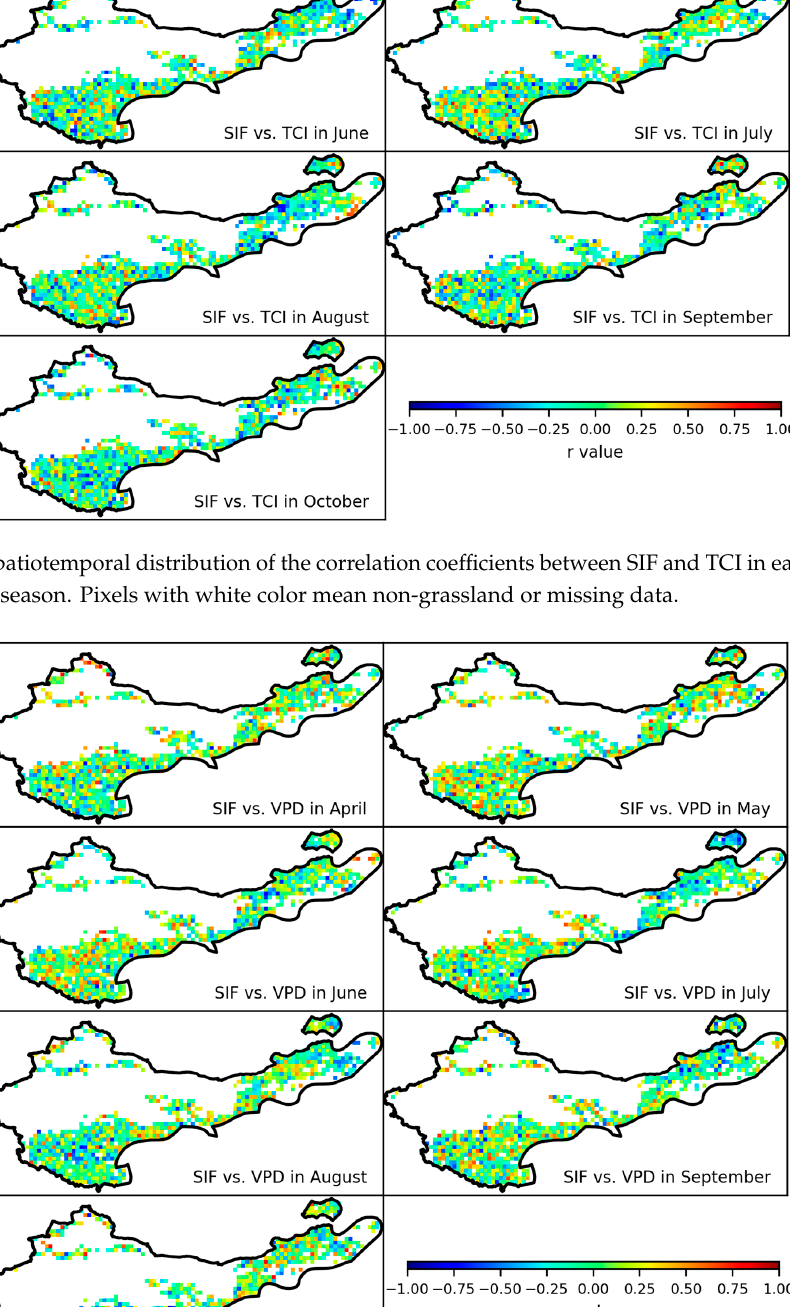
Figure 8. Spatiotemporal distribution of the correlation coefficients between SIF and VPD in each month of growing season. Pixels with white color mean non-grassland or missing data.